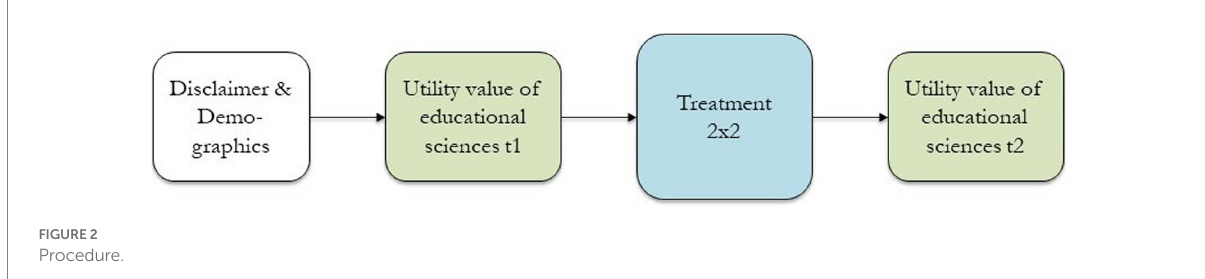
FIGURE 2 Procedure.